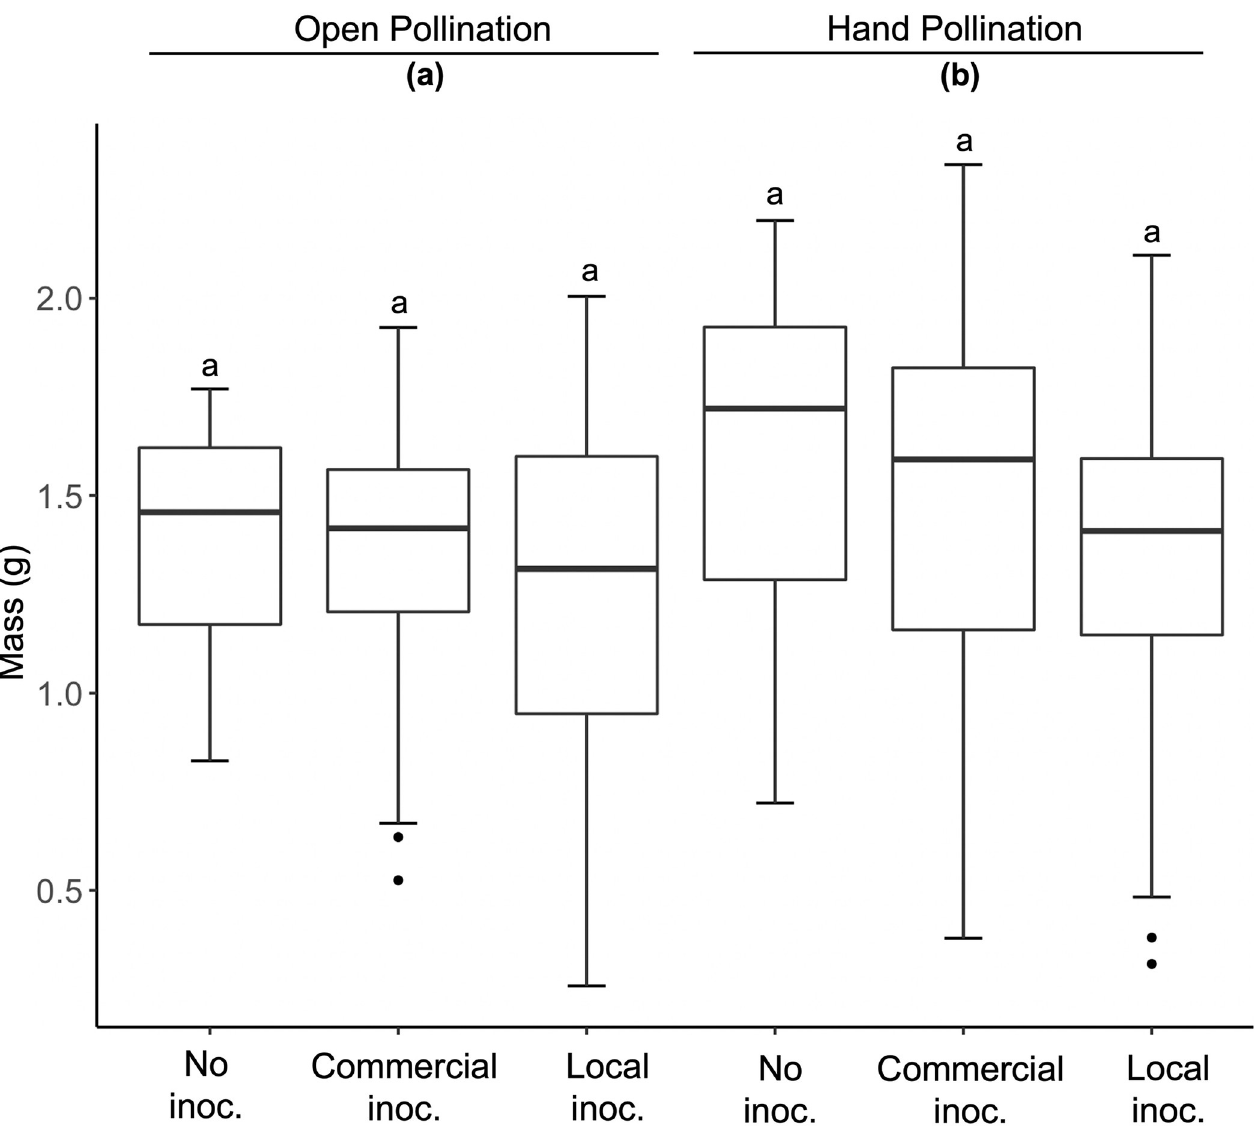
Fig 3. The mean individual berry mass for the non-inoculated control, commercial inoculum, and local soil in 2019. Results were analyzed using a linear mixed effects model. Letters denote differences among treatment groups using R package “emmeans”.